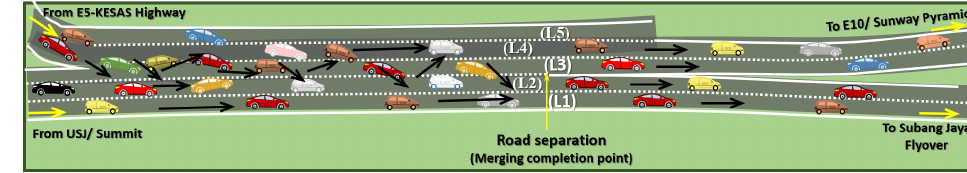
Figure 1. The study route in Subang Jaya, Malaysia: an actual traffic scenario in which vehicles from two roads merge and divert in two ways over a short distance, causing massive congestion every